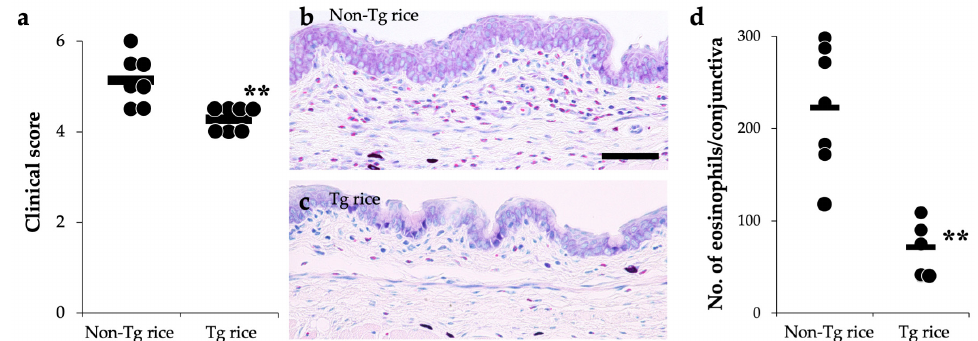
Figure 2. Prophylactic administration with Tg rice suppresses the development of allergic conjunc- tivitis. Mice were fed with Tg rice seed or control (non-Tg) rice seed ad libitum for 14 d before the first sensitization with birch pollen. At 20 min after the last birch pollen challenge, clinical appearance was evaluated. ** p < 0.01, Tg vs. non-Tg rice-fed group according to an unpaired Student’s t test (seven mice per group) ( a ). At 24 h after the third challenge, the eyes were isolated for histological analysis according to the number of eosinophils in the conjunctiva ( b – d ). ** p < 0.01, Tg vs. non-Tg rice-fed group according to the Mann–Whitney U test (non-Tg rice group: seven mice per group and Tg rice group: five mice per group). The dots and bars within ( a , d ) indicate mean values for the two eyes of each mouse and the overall median values, respectively.